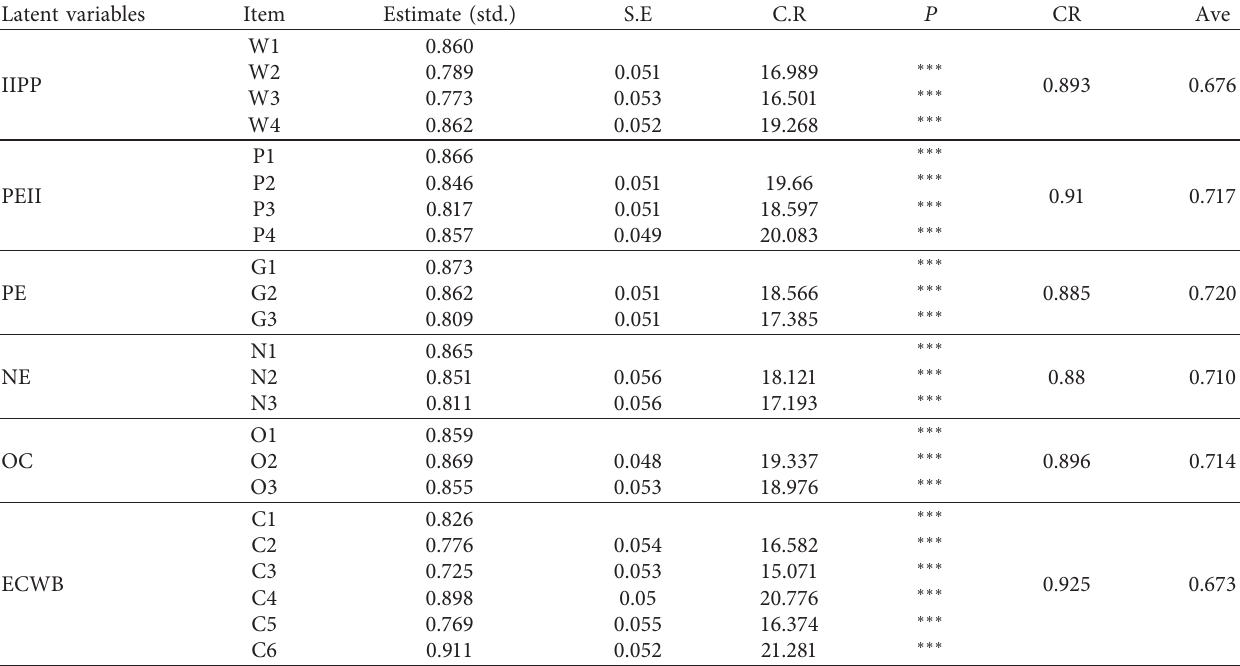
Table 2: Analysis of convergence